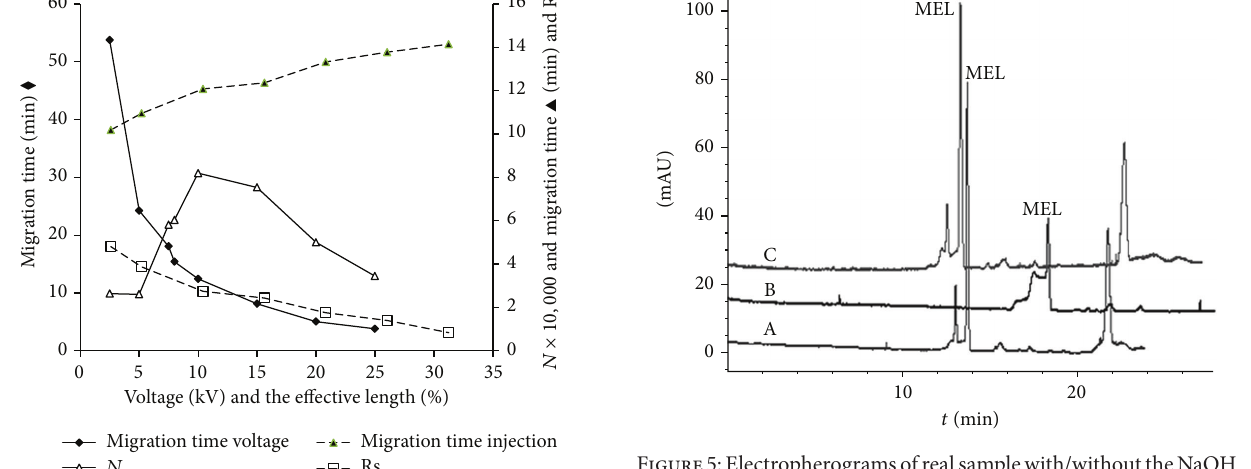
times and peak areas. Linearity range, using area as